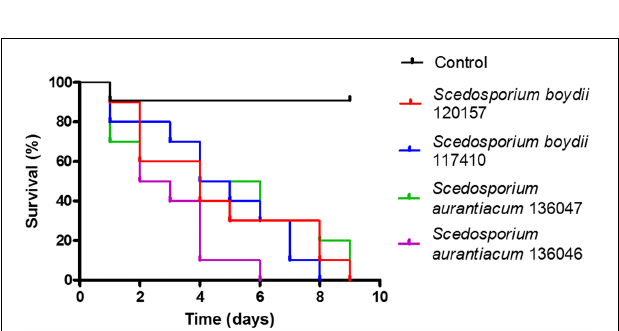
FIGURE 8 | In vivo infection model of Galleria mellonella . An in vivo infection model was performed in which we infected 10 larvae per group with 10 6 conidia of one of the strains used in this study. The control group was inoculated with PBS. Each population was observed daily for 9 days. The survival results are shown. Statistical differences ( P < 0.05) are represented by